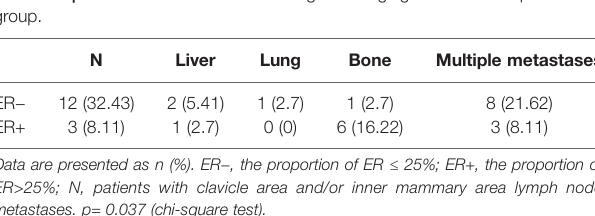
TABLE 4 | Detailed sites of lesions leading to changing the treatment plan in C1 group.